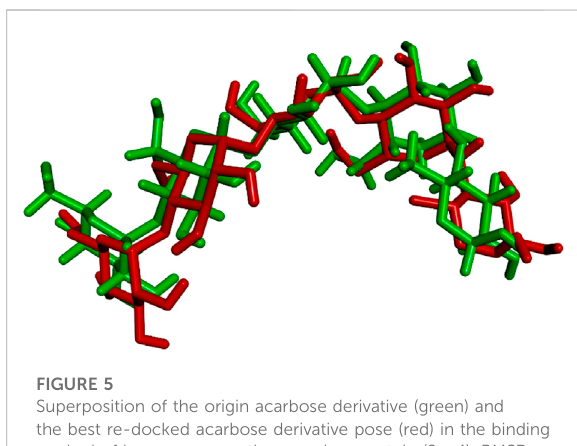
FIGURE 5 Superposition of the origin acarbose derivative (green) and the best re-docked acarbose derivative pose (red) in the binding pocked of human pancreatic α -amylase protein (2qv4). RMSD value equal to 1.298